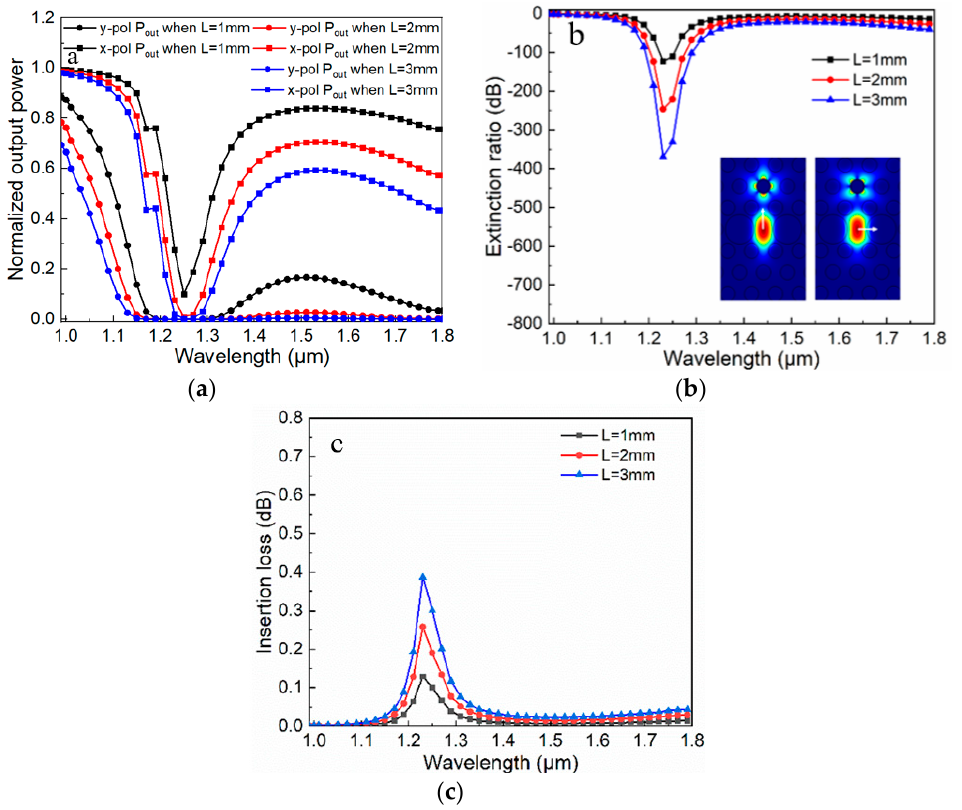
Figure 8. Performance parameters versus wavelength with different fiber length L for the single-ring structure filter. ( a ) Normalized output power versus wavelength; ( b ) Extinction ratio versus wavelength, and resonance modes for single-ring structure filter; ( c ) Insertion loss versus wavelength. Table 2. Performance comparison between the proposed filter and prior filters.